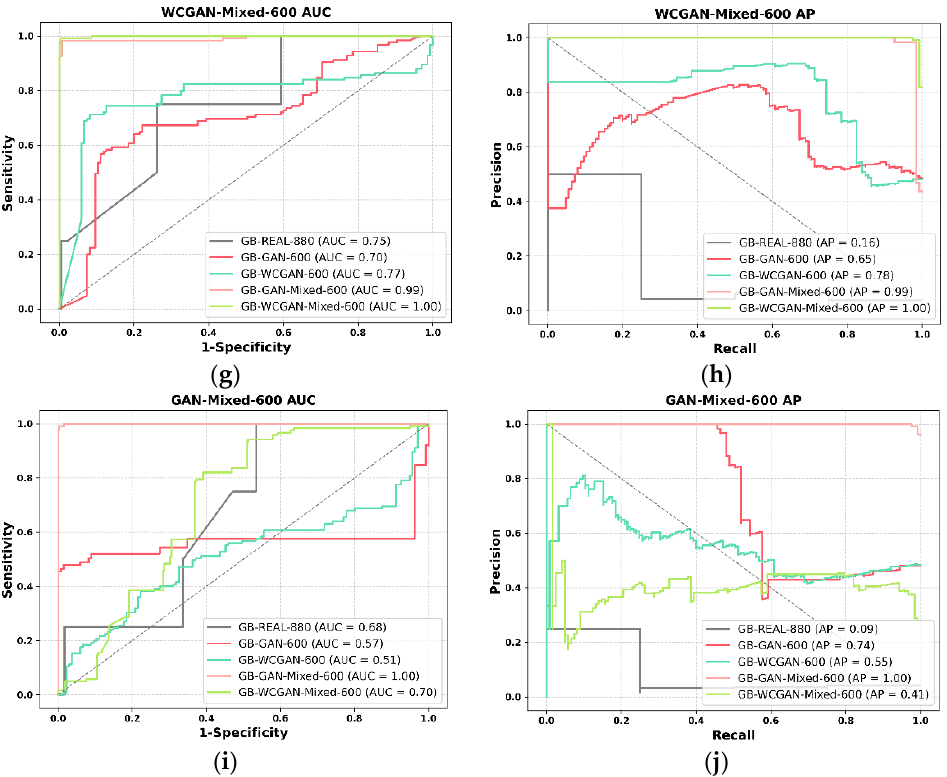
Figure 17. Concept graph presenting ROC and Precision–Recall curves: ( a ) ROC curve for all the GB-based classifiers for the REAL-880 data set; ( b ) Precision–Recall curve for all the GB-based classifiers for the REAL-880 data set; ( c ) ROC curve for all the GB-based classifiers for the WCGAN-600 data set; ( d ) Precision–Recall curve for all the GB-based classifiers for the WCGAN-600 data set; ( e ) ROC curve for all the GB-based classifiers for the GAN-600 data set; ( f ) Precision–Recall curve for all the GB-based classifiers for the GAN-600 data set; ( g ) ROC curve for all the GB-based classifiers for the WCGAN-Mixed-600 data set; ( h ) Precision–Recall curve for all the GB-based classifiers for the WCGAN-Mixed-600 data set; ( i ) ROC curve for all the GB-based classifiers for the GAN-Mixed-600 data set; ( j ) Precision–Recall curve for all the GB-based classifiers for the GAN-Mixed-600 data set.